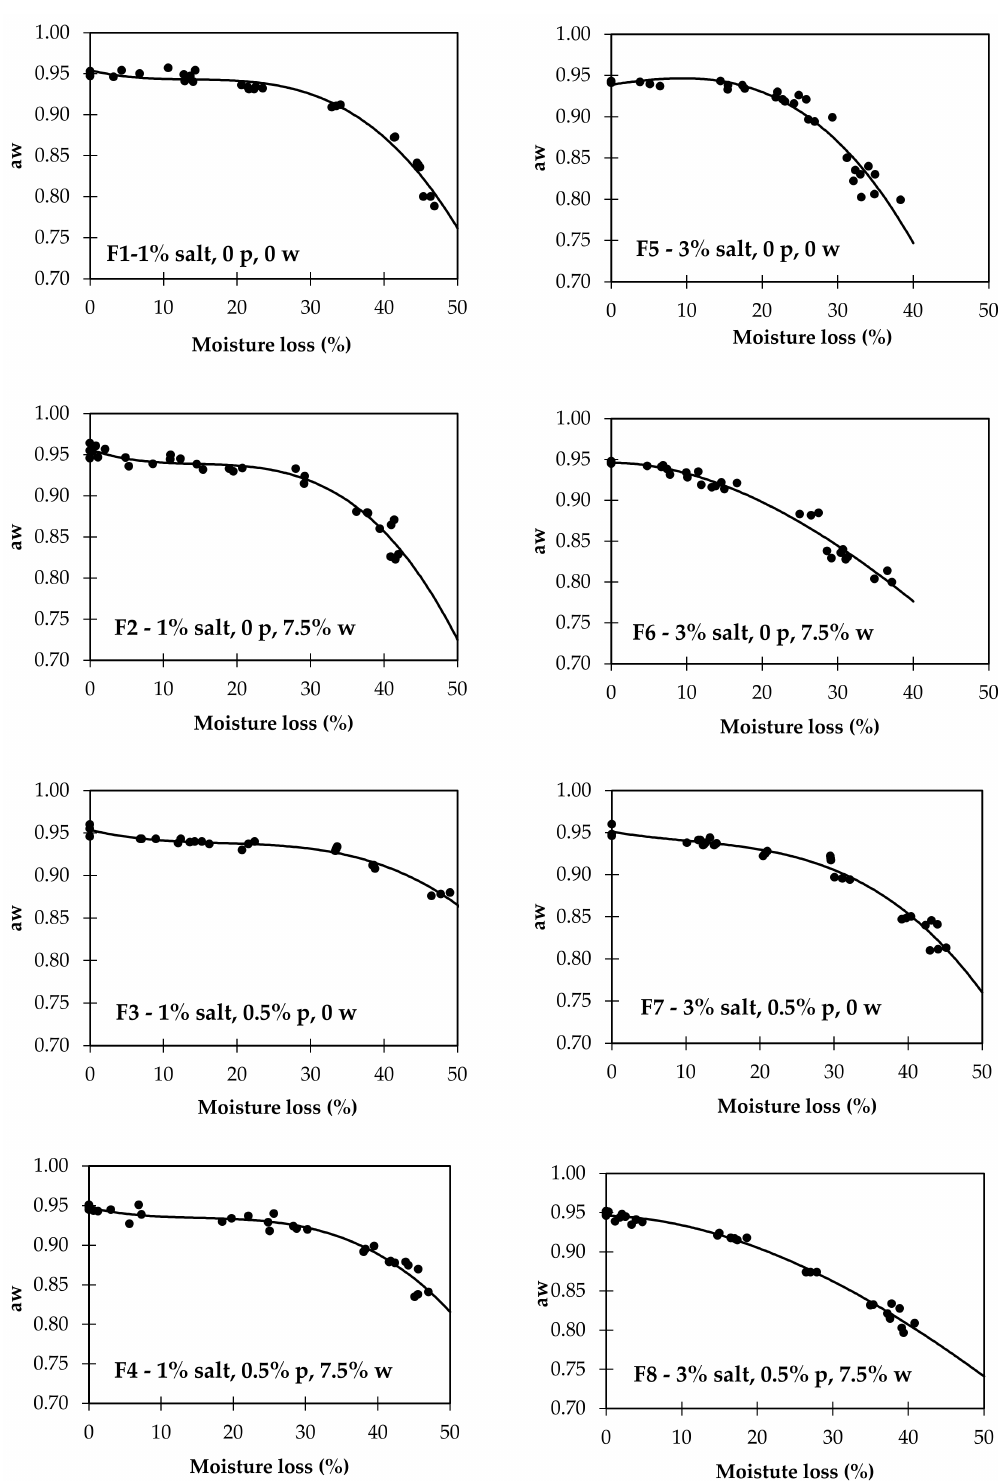
Figure 4. Nonlinear regression between aw and moisture loss for the eight formulations tested ( n = 30). p—phosphate;